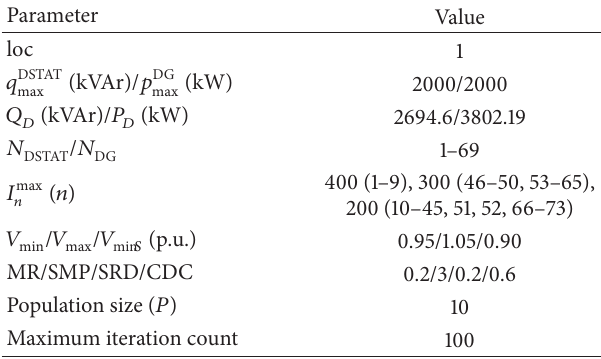
Table 2: Selected design parameters.